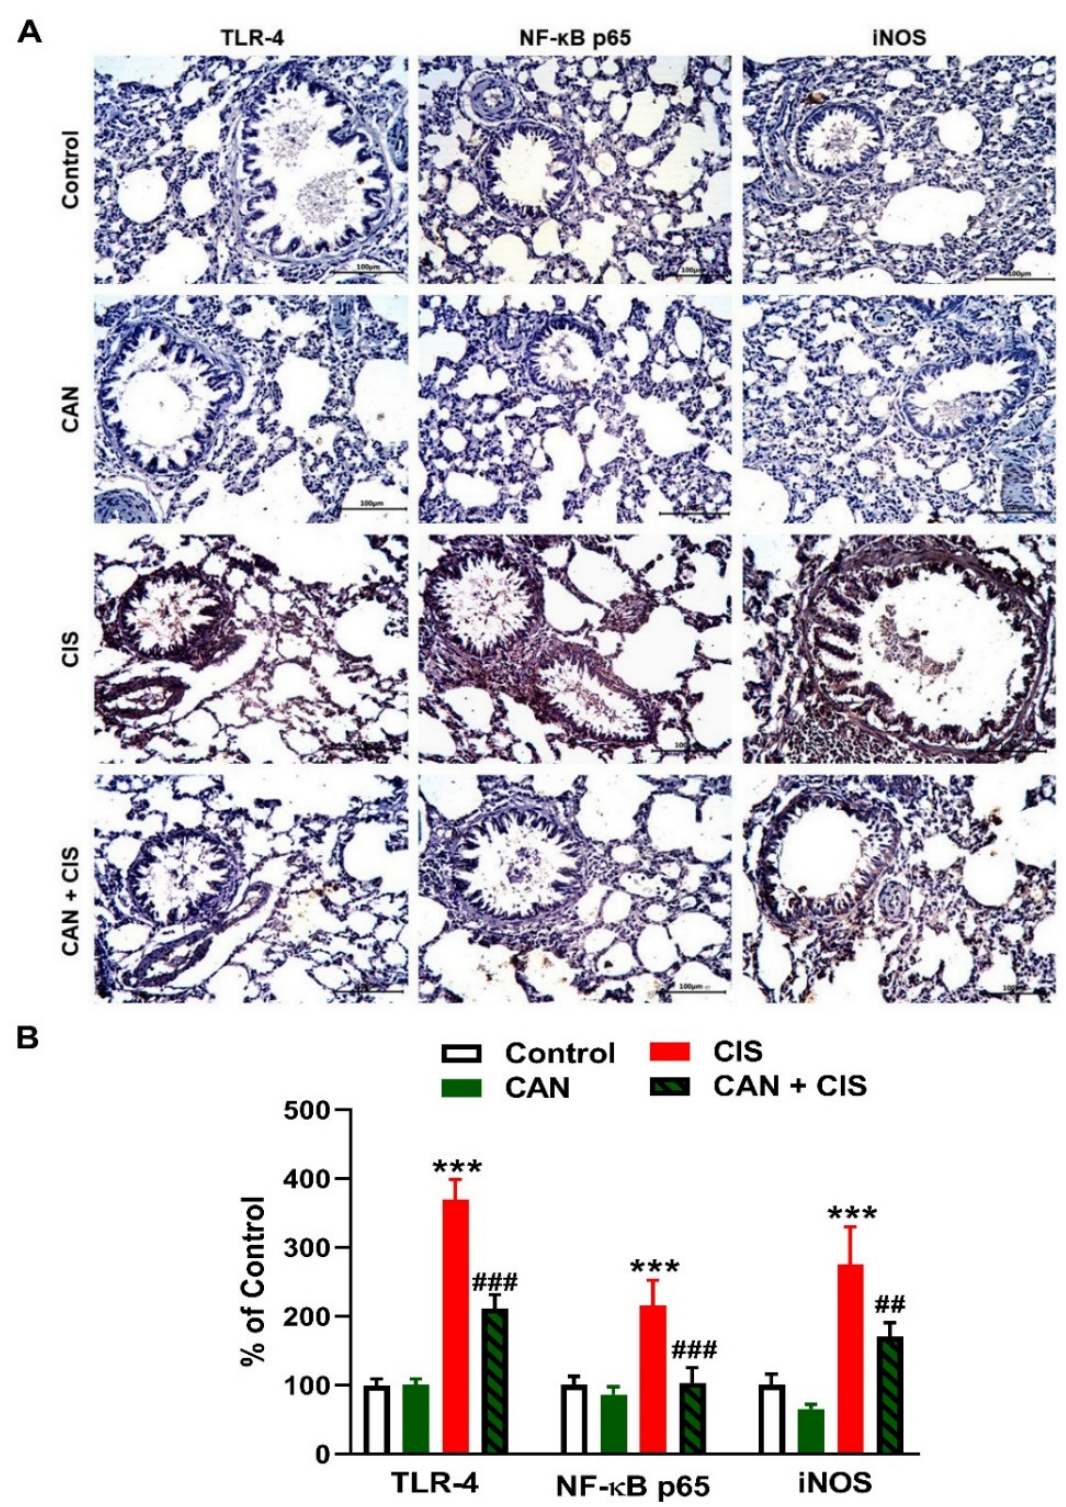
Figure 3. CAN downregulated TLR-4/NF- κ B signaling in CIS-administered rats. ( A ) Photomicro- graphs of sections in the lungs of rats showing increased expression of TLR-4, NF- κ B p65, and iNOS in CIS-administered rats and a marked decrease in CAN-treated rats. ( B ) Image analysis showed that CAN significantly decreased TLR-4, NF- κ B p65, and iNOS in CIS-administered rats. Data are Mean ± SEM, ( n = 8). *** p < 0.001 versus Control, and ## p < 0.01 and ### p < 0.001 versus CIS.